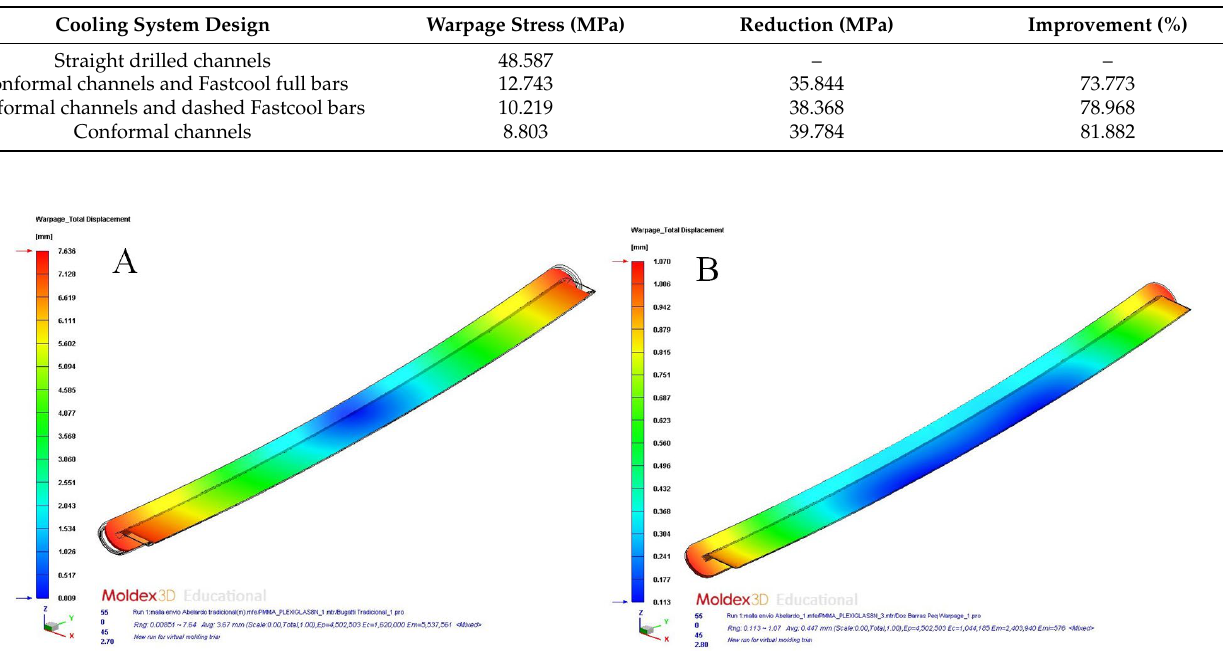
Figure 17. Total warpage (mm); straight drilled channels ( A ), conformal channels—Fastcool full bars ( B ).